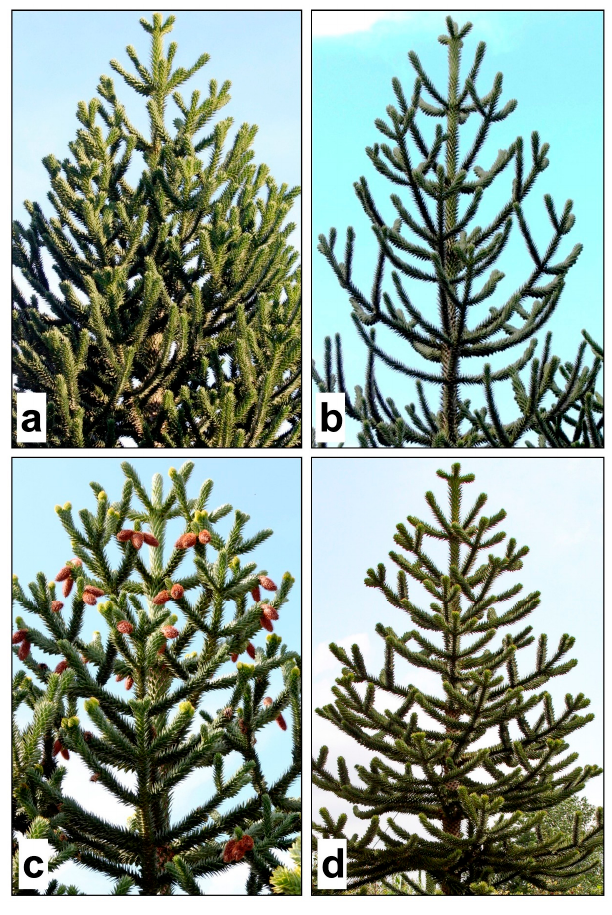
Figure 2. Canopy appearance of the four putative A. araucana populations: ( a ) NLU; ( b ) UNK; ( c ) ESU; ( d )